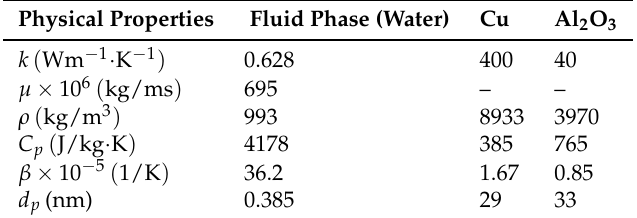
Table 1. Thermo-physical properties of water, Cu nanoparticles, and Al 2 O 3 nanoparticles at T = 310 K